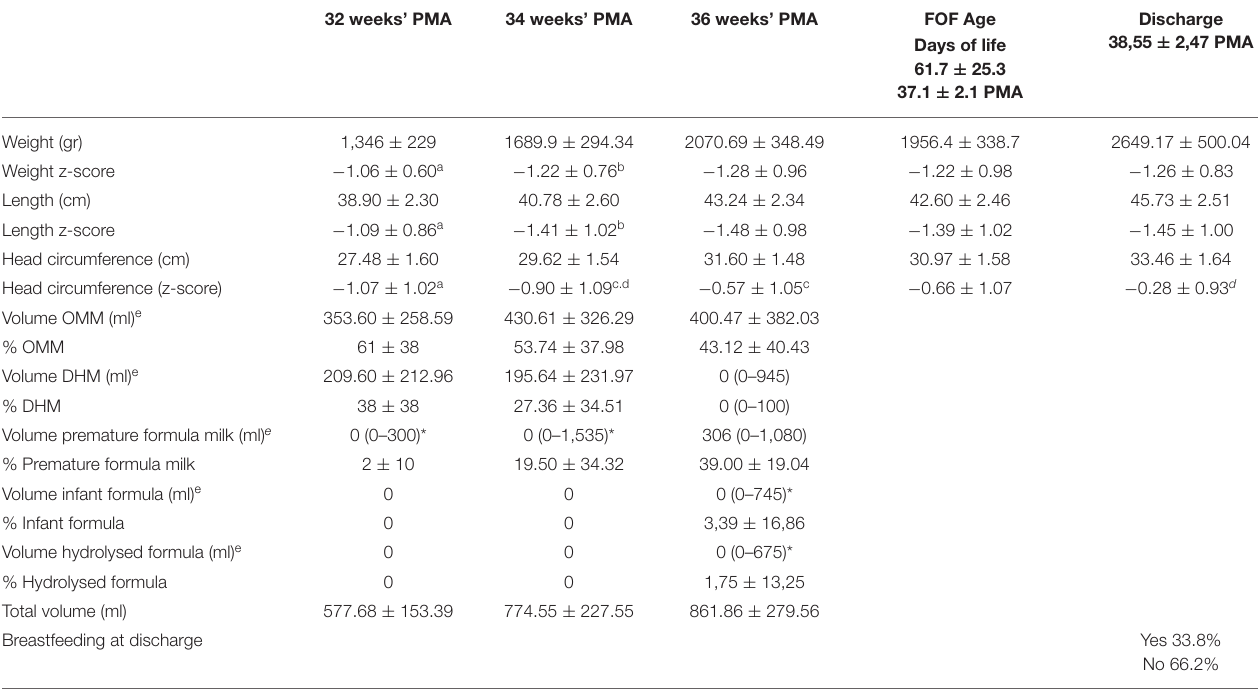
TABLE 2 | Evolution of growth and type of lactation during admission.